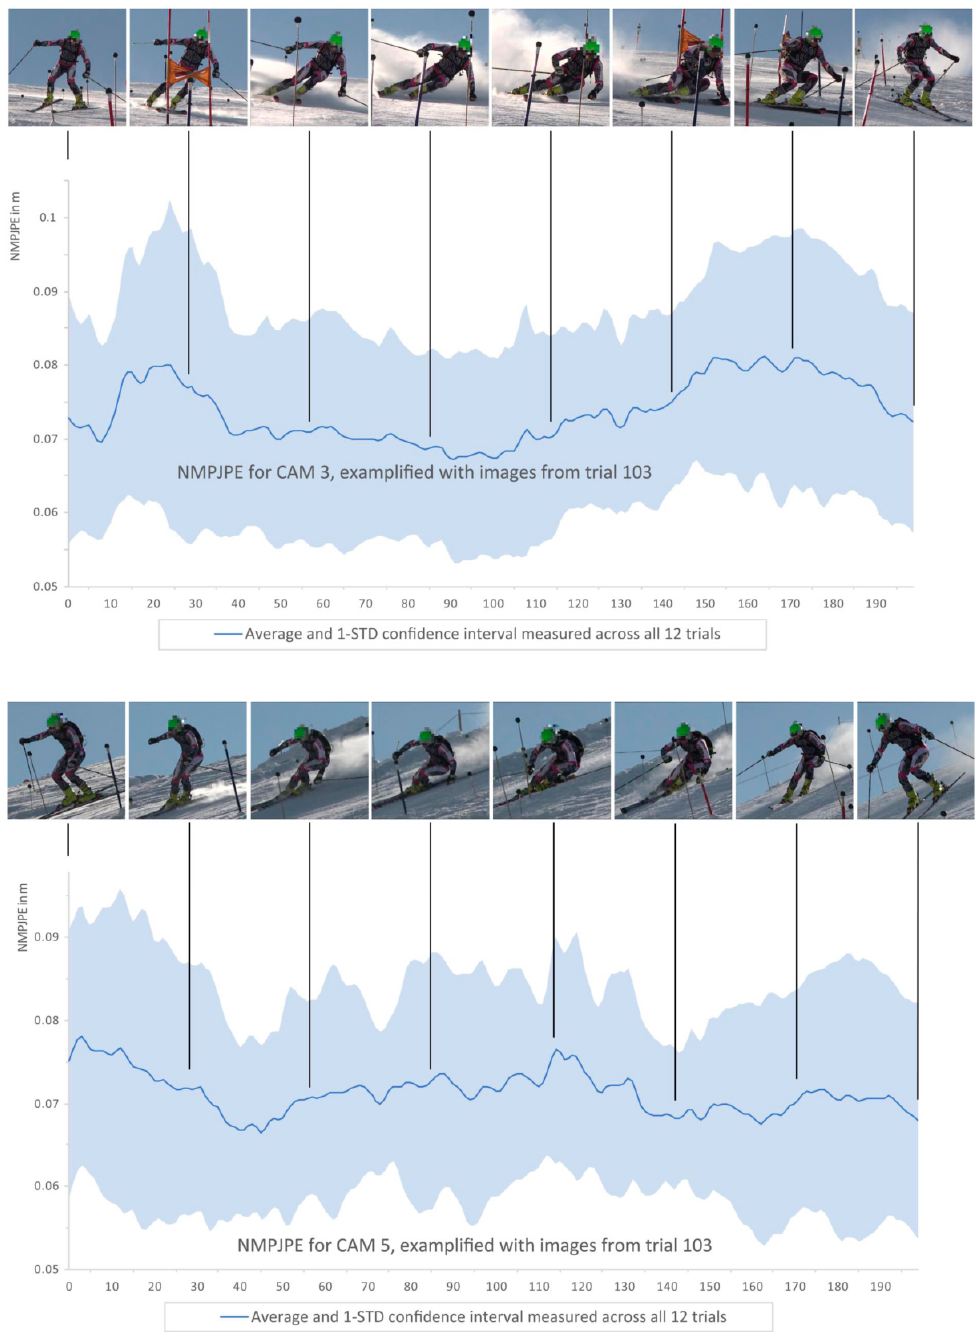
Figure 4. Normalized mean per joint position error (NMPJPE) for the best camera perspectives (CAM 3 and CAM 5; frontal-lateral) over one turn cycle.